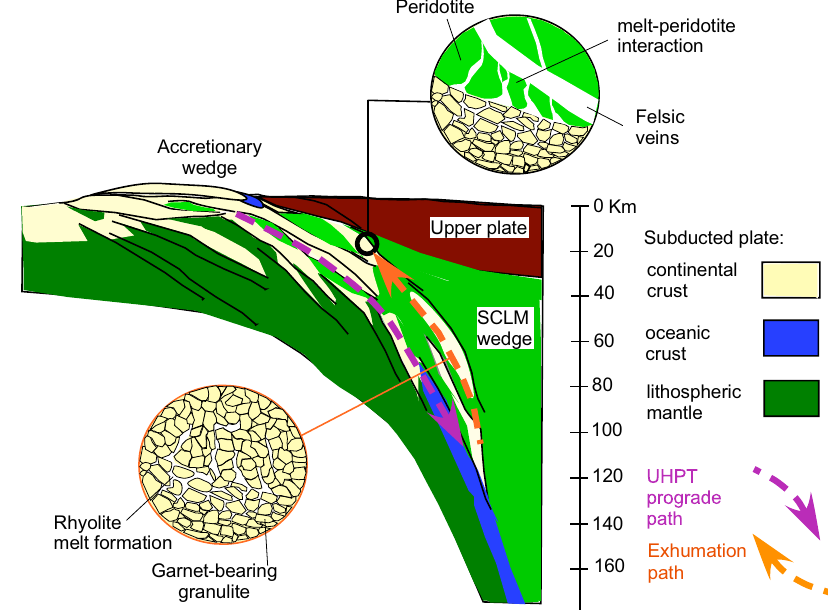
Fig. 6 | Cartoon showing the subduction and exhumation of continental crust sliverswiththeformationofrhyolitemelts. Notethatintheconceivedmodelthe subducted crustal blocks (and the entrained rhyolite melts) are subsequently exhumed to shallower mantle depths during slab roll back processes in relation to their relative buoyancy. Finally, rhyolite melts segregate and escape from the crustalsourcesand interactwith the surrounding peridotite bodies, within a crust-